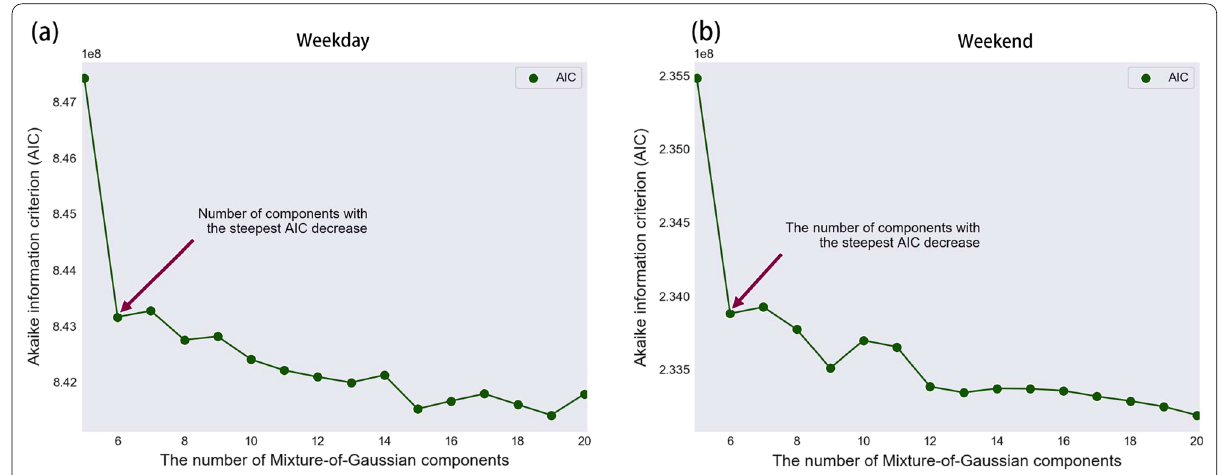
Fig. 7 Akaike information criterion values for the weekday and weekend models. a Weekday. b Weekend